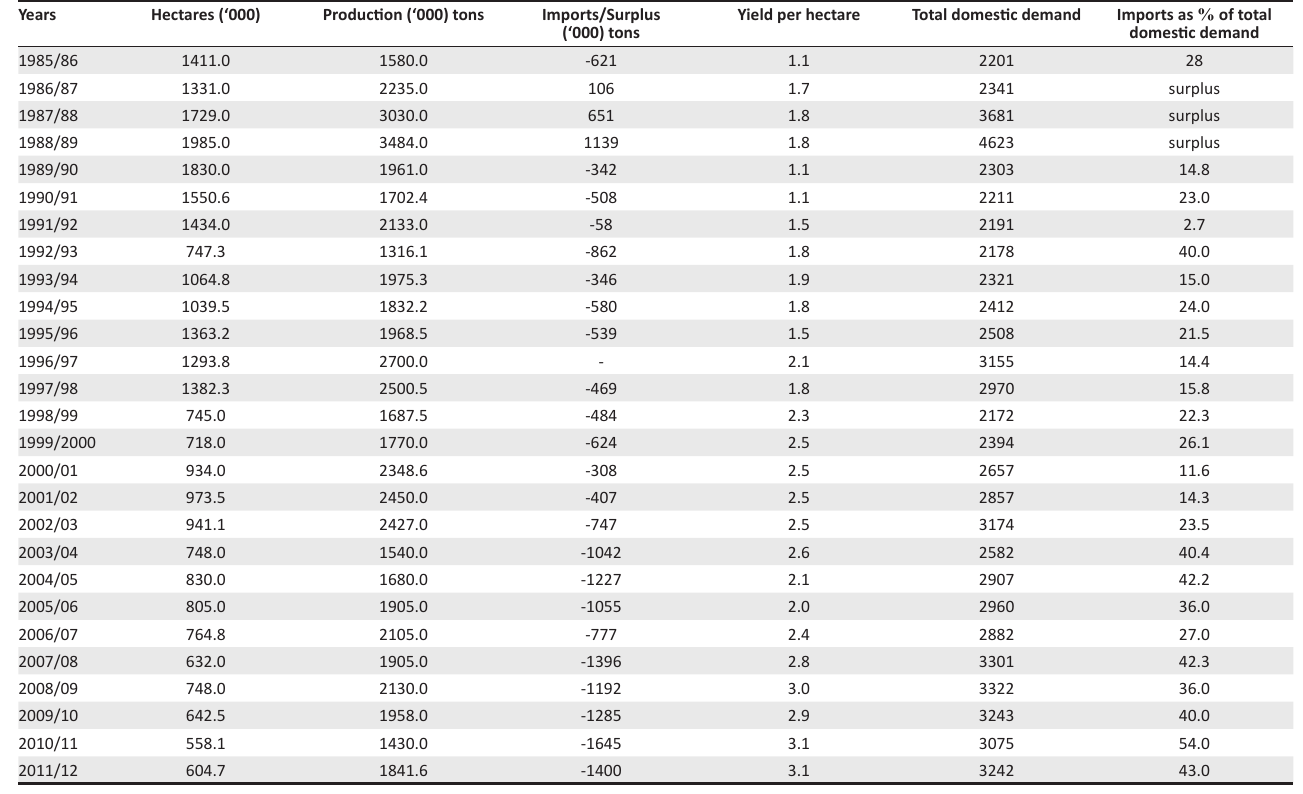
TABLE 2: Structural changes to the wheat market for the years 1985/1986 to 2011/2012.